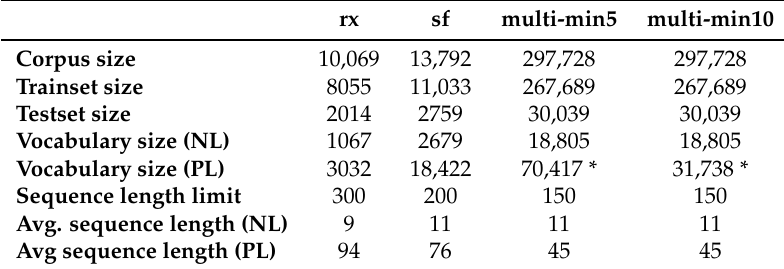
Table 2. Properties of datasets used in the experiments described in Section 5. NL refers to natural language and PL—to programming language.